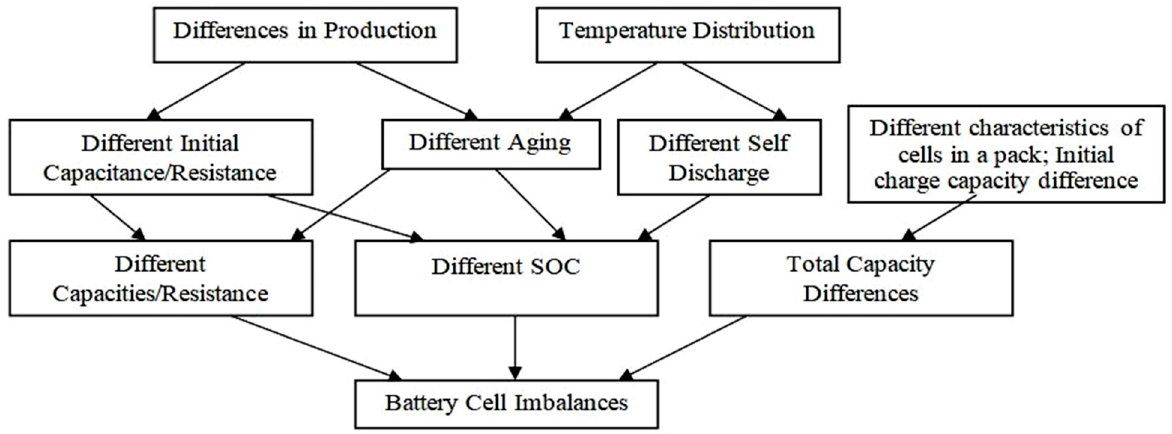
Figure 6. Reasons for cell imbalances [6,14].